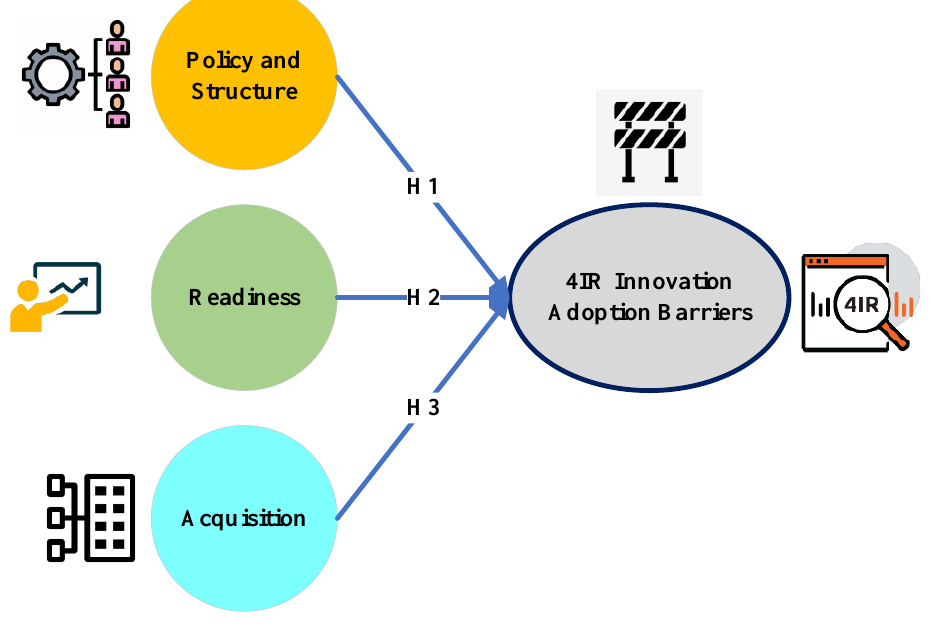
Figure 2. Research conceptual framework.